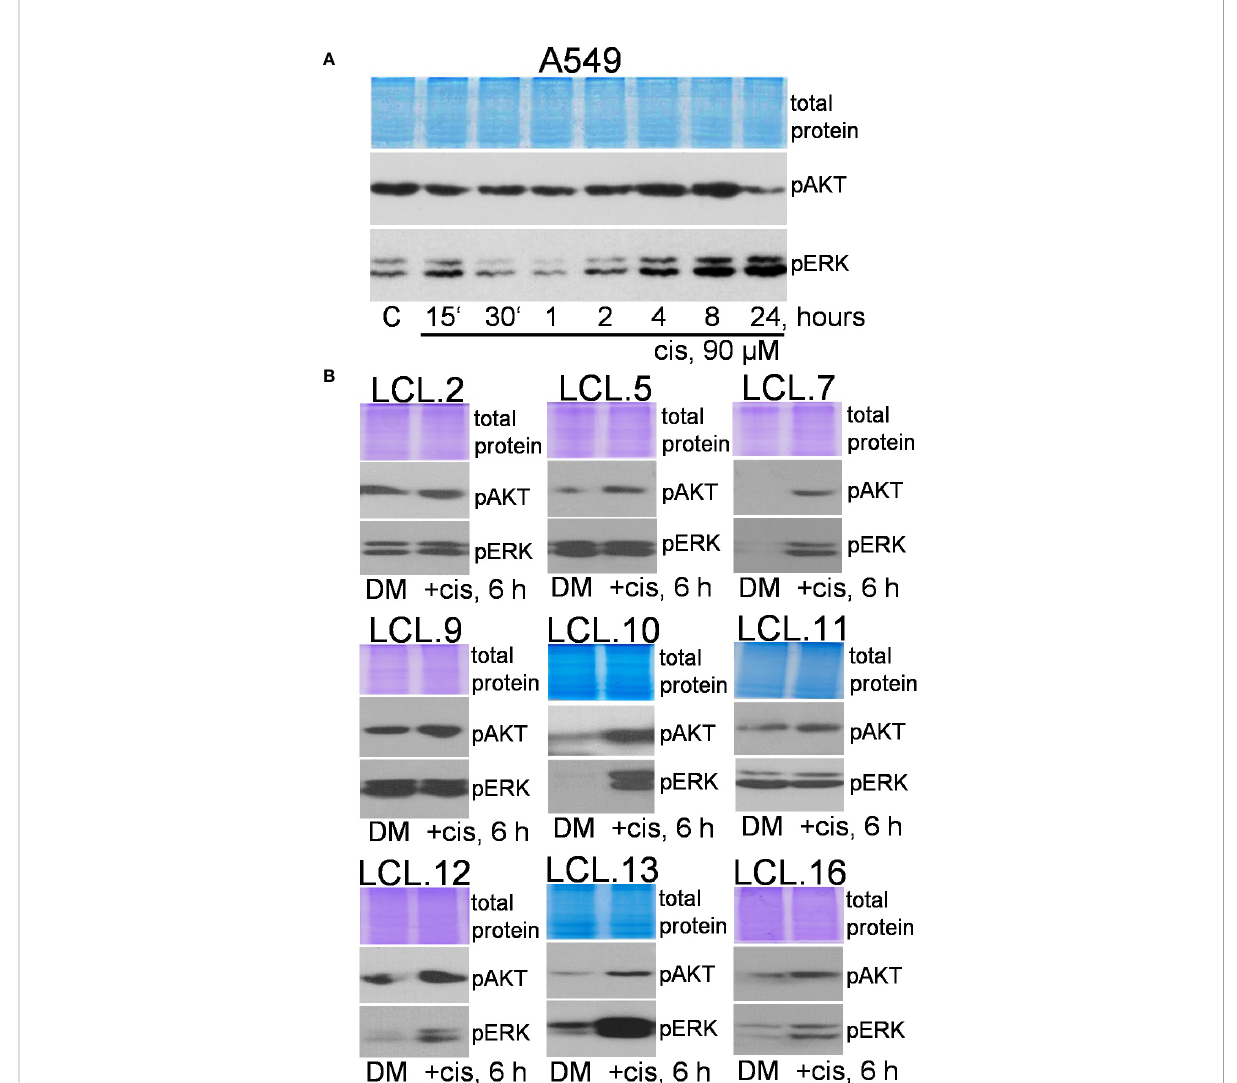
FIGURE 4 Phosphorylation of ERK1/2 and AKT in lung cancer-derived cell lines after cisplatin treatment. (A) The dynamics of AKT and ERK phosphorylation in A549 cells. (B) Changes in AKT and ERK phosphorylation in lung tumor-derived cell lines after 6 hours of cisplatin treatment. Representative Western blots are shown. Coomassie-stained protein gels are presented as loading controls. The concentration of cisplatin was 90